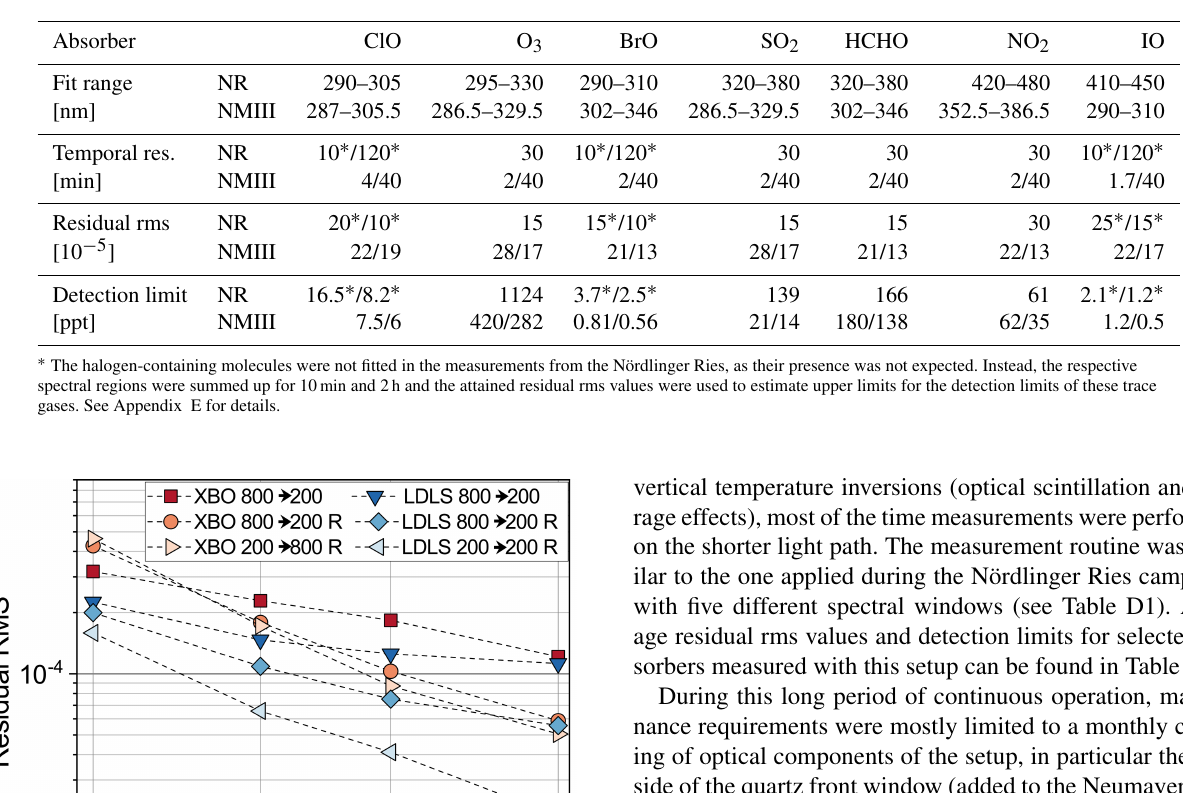
Table 6. Attained measurement performance for the detection of different absorbers during the field campaign in the Nördlinger Ries, Germany (NR; total light path: 5.7km), and during the long term observations on the German Antarctic Station Neumayer III (NMIII; total light paths: 3.1 and 5.9km). Where two values are available, attainable residual rms and detection limits for two different summations, and hence temporal resolutions corresponding to 10min (left value) and 30min to 2h (right value), are indicated. Absorber ClO O 3 BrO SO 2 HCHO NO 2 IO